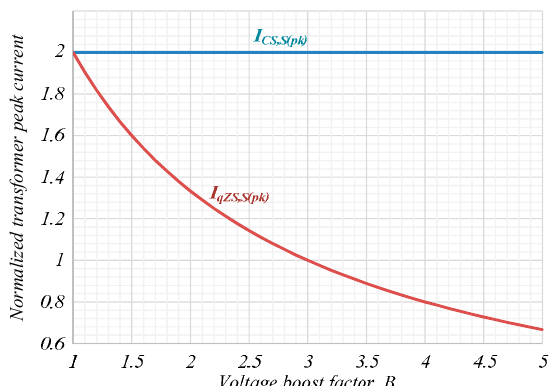
Figure 13. Normalized peak current of the transformer input winding as a function of the input voltage boost factor B .